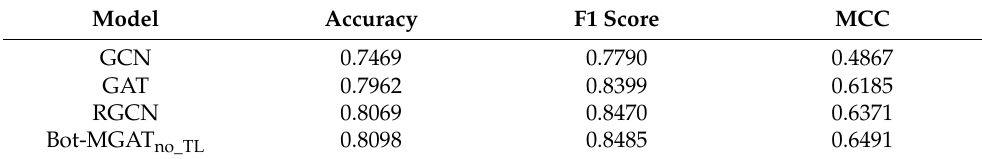
Table 5. Bot-MGAT without TL compared to other GNN models. Model